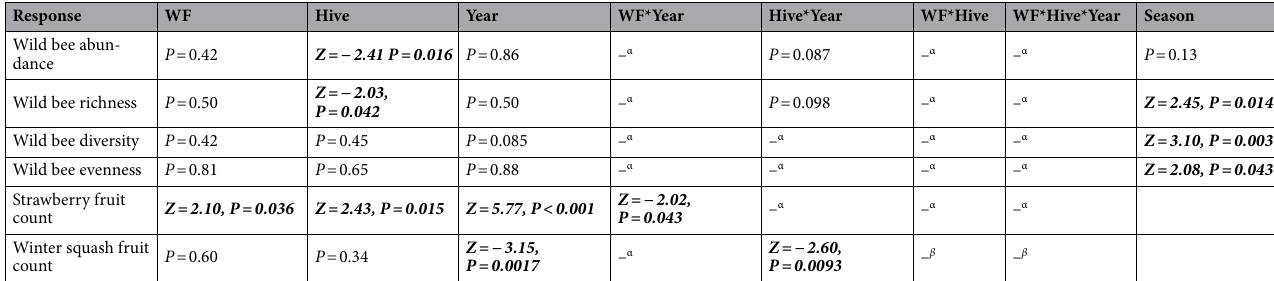
Table 1. Wild bee survey data (abundance, species richness, Shannon–Wiener diversity, and species evenness) and fruit count data in response to wildflower strip (WF) and hive presence/absence, year, and/or season.